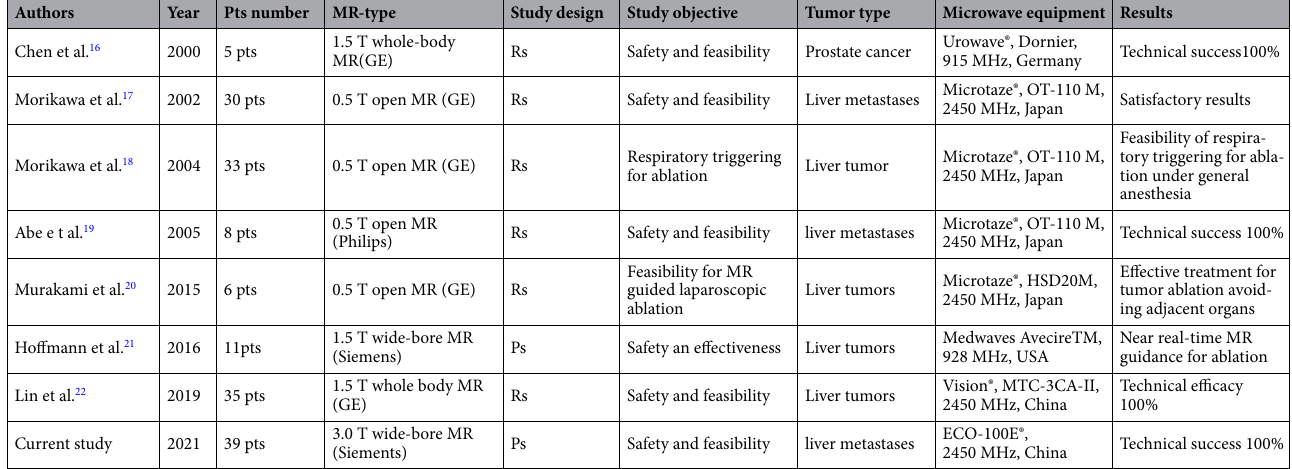
Table 5. Clinical studies published on MR-guided Microwave ablation. Pts: patients; RS: retrospective study; Ps: perspective